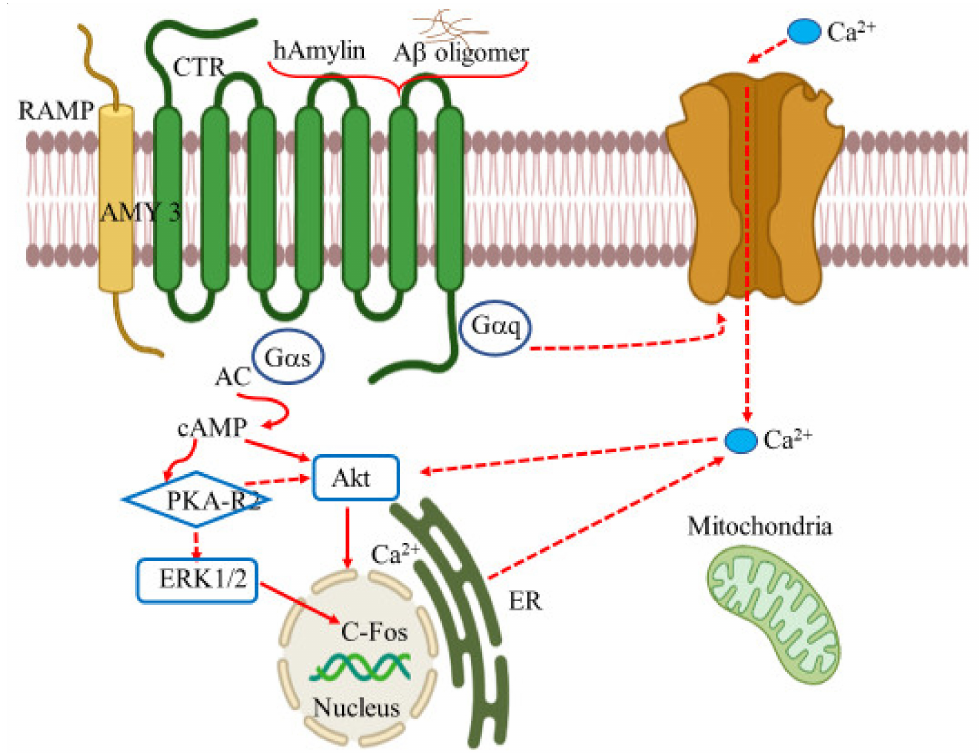
Figure 6. The AMY 3 is a heterodimeric complex of calcitonin receptor and receptor activity modifying protein 3. In AD, Amyloid β (A β ) peptide activates AMY 3 subtype receptors by promoting multiple intracellular signaling pathways which is demonstrated in the above figure. The interaction of Human amylin (hAmylin) and A β together leads to activation AMY 3. The activation of AMY3 stimulates G-Protein G α s which further control the adenylate cyclase (AC), followed by an increase in cellular cAMP. Binding of cAMP to the PKA regulatory subunits (R 2 ) induces dissociation of the tetrameric PKA holoenzyme, resulting in activation of PKA catalytic subunits. cAMP-activated PKA is involved in the regulation of Erk1/2 activities. The triggering of the ERK1/2 pathway may cause uneven distribution of Ca 2+ trigger the dysfunction of the endoplasmic reticulum (ER) and mitochondria and result in cell death. In addition, cAMP stimulates Akt which further leads to transcription factor cFos expression. Created with